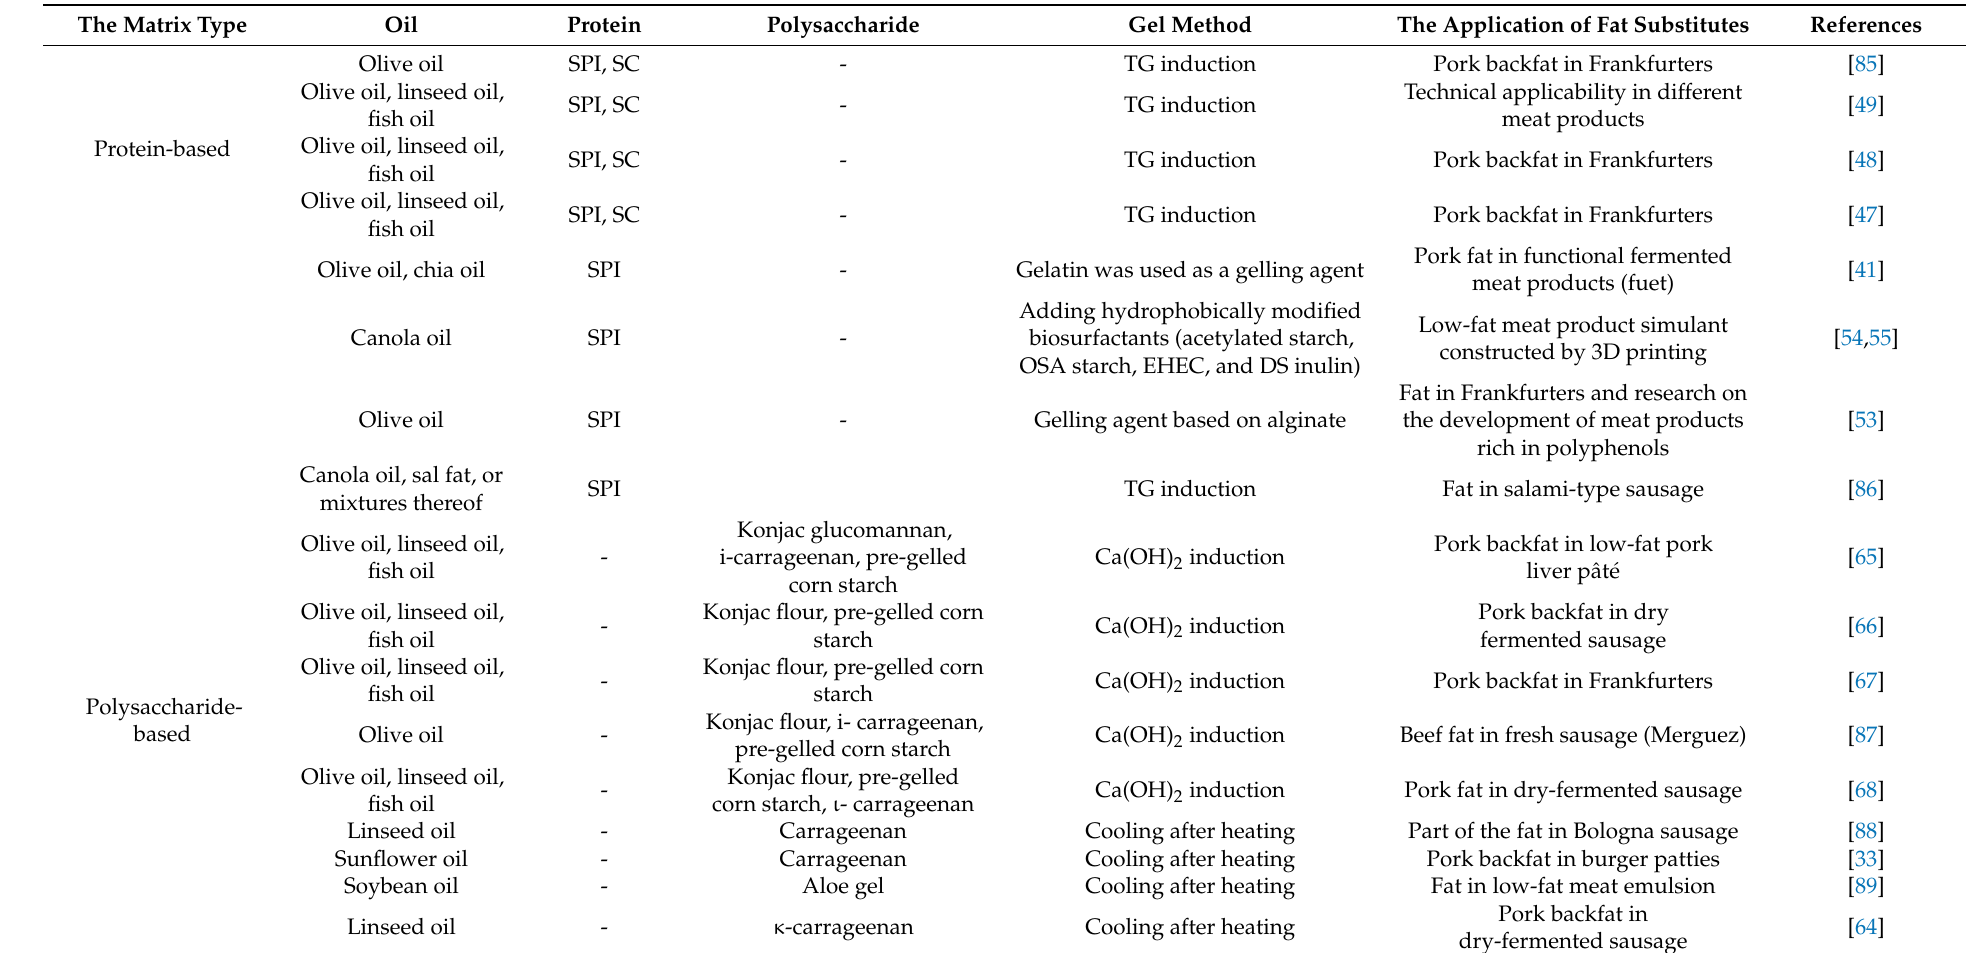
Table 1. The application of emulsion gels with different matrices as fat substitutes in meat